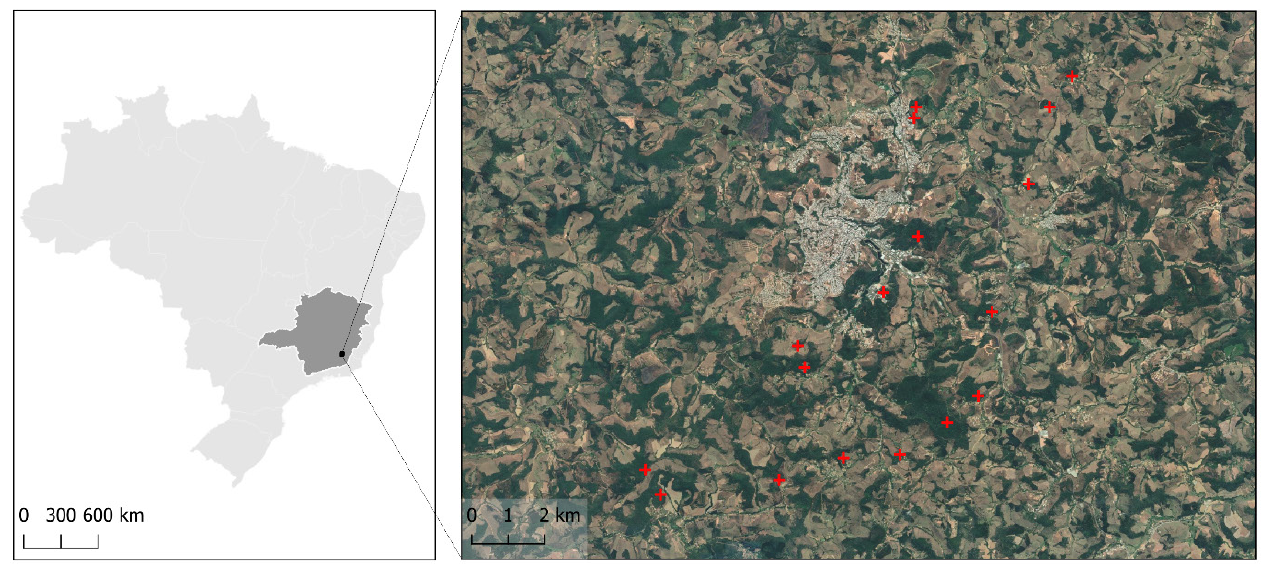
Fig 1. Map of sampled Atlantic rain forest fragments in Viçosa region, Minas Gerais state, Brazil. The red crosses show the location of the 17 fragments sampled in 1995, 1996 and